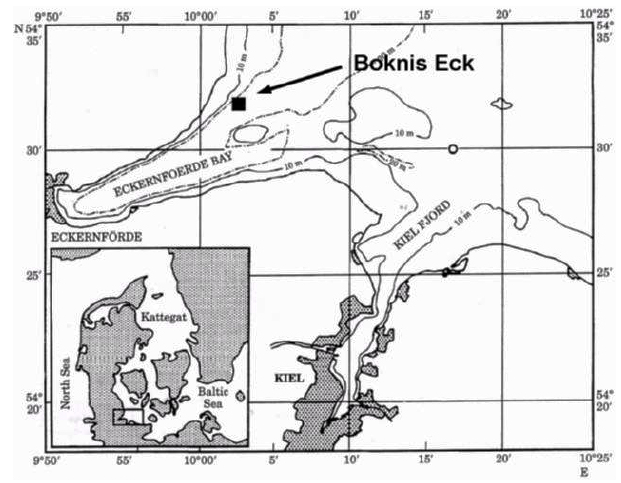
Figure 1. Location (black square) of the Boknis Eck Time Series Station in Eckernförde Bay, southwestern Baltic Sea (from Hansen et al.,